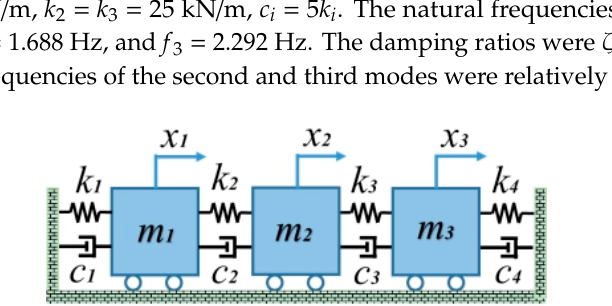
Table 1. Load information of the three stages.